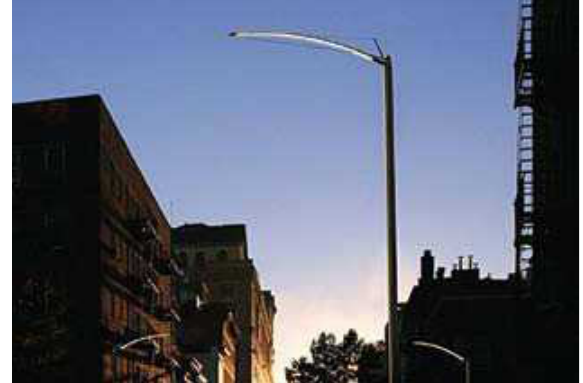
21 pav. Niujorko gatvių apšvietimo konkursą laimėjęs šviestuvas, 2004 m. Fig. 21. New York city Street Lighting Design competition,